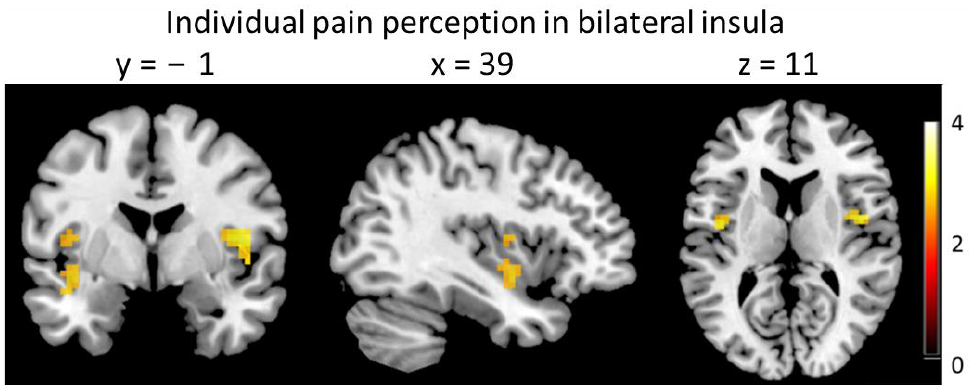
Figure 5. Individual pain perception relates to insula activity during the stimulation period, p < 0.001, clusters-size >10 for display purpose.